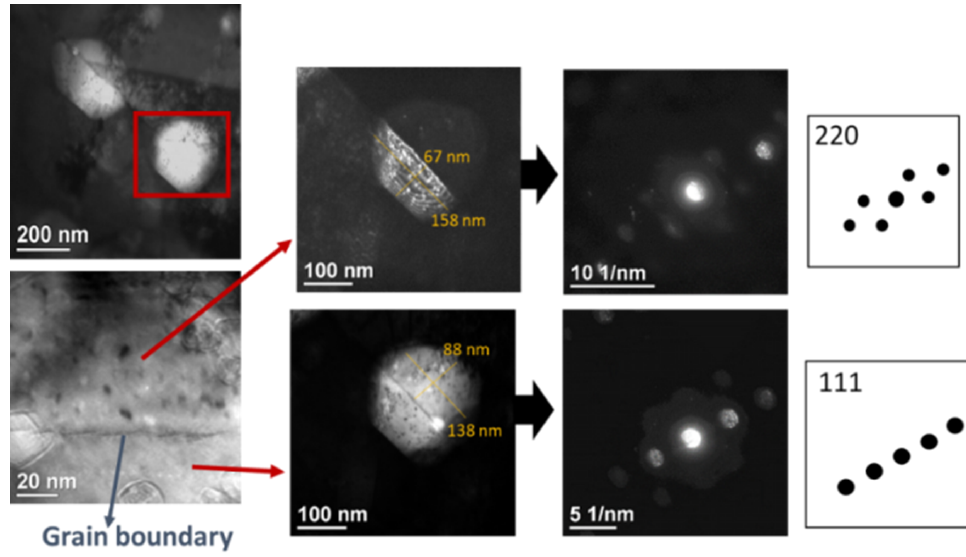
Figure 6. TEM analysis of two grains at two different orientations for APS sample without H 2 treatment.